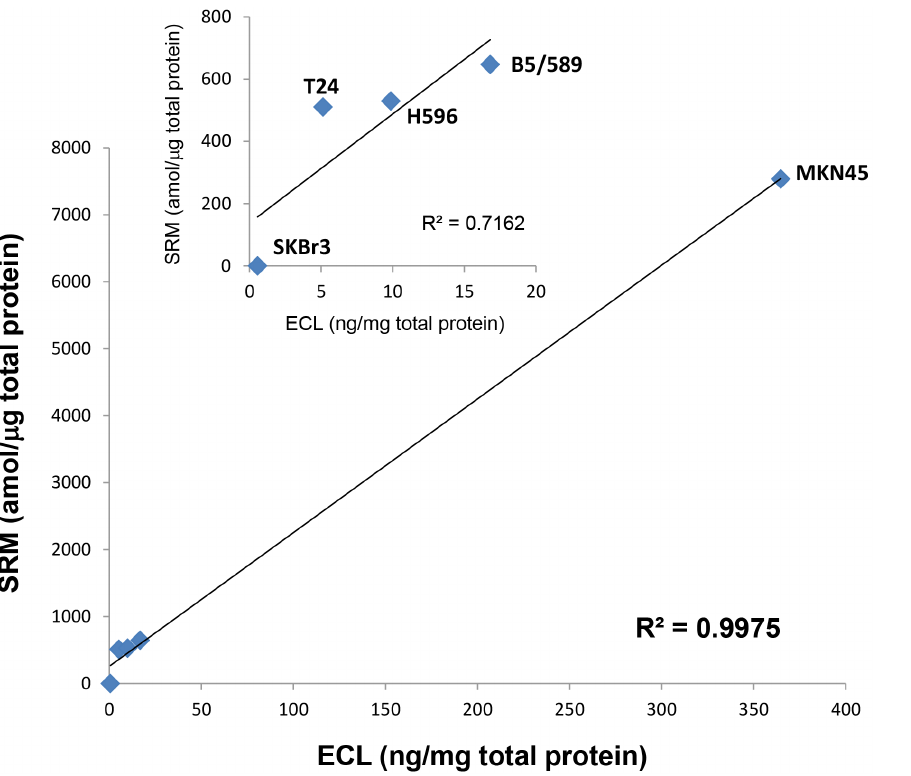
Figure 4. Comparison of Met levels measured in five different cell lines using Liquid Tissue-SRM and an electrochemiluminescent (ECL) immunoassay. Inset: comparison of SRM and ECL Met levels measured within the four cell lines containing the lowest concentration of Met.